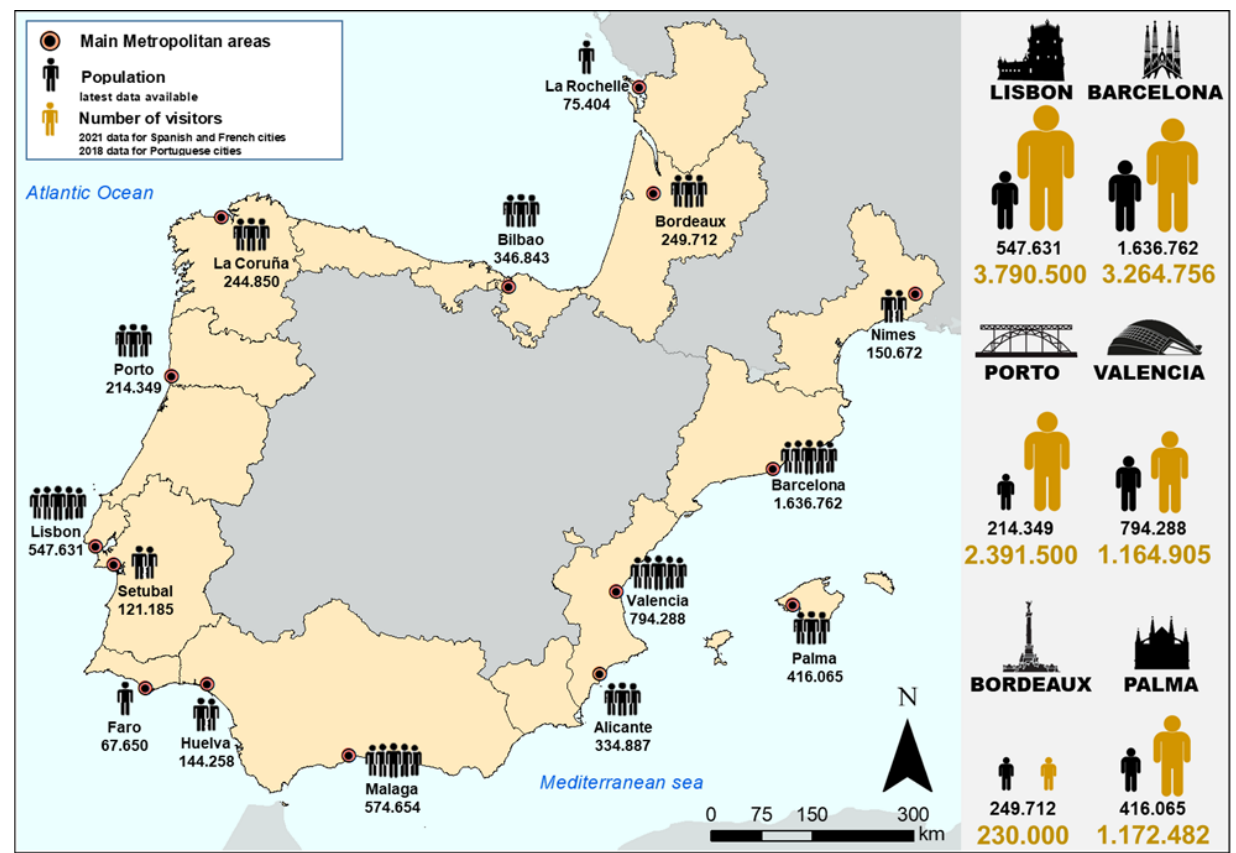
Figure 1. The 20 coastal regions of southwest Europe analysed in this paper, including 3807 km of Atlantic coastline and 4227 km of Mediterranean coastline. The most populated cities and the annual number of visitors for each are indicated. Data from [21 – 26].